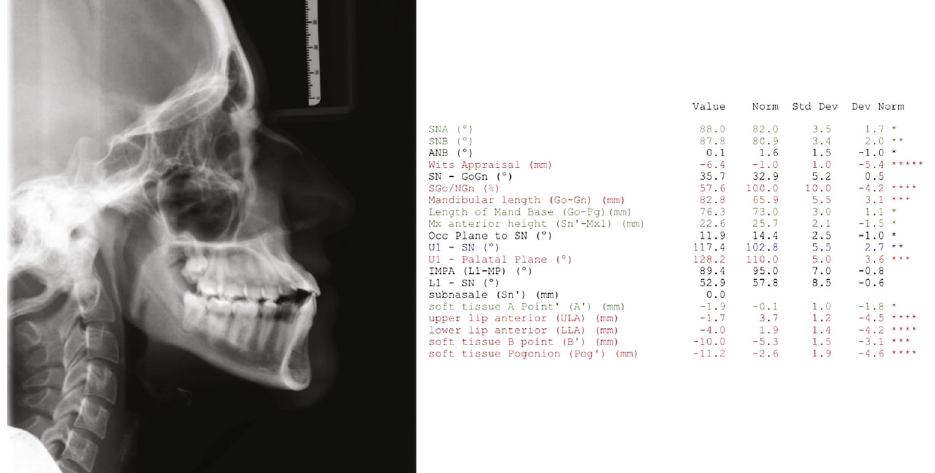
Figure 4: Pretreatment cephalometric